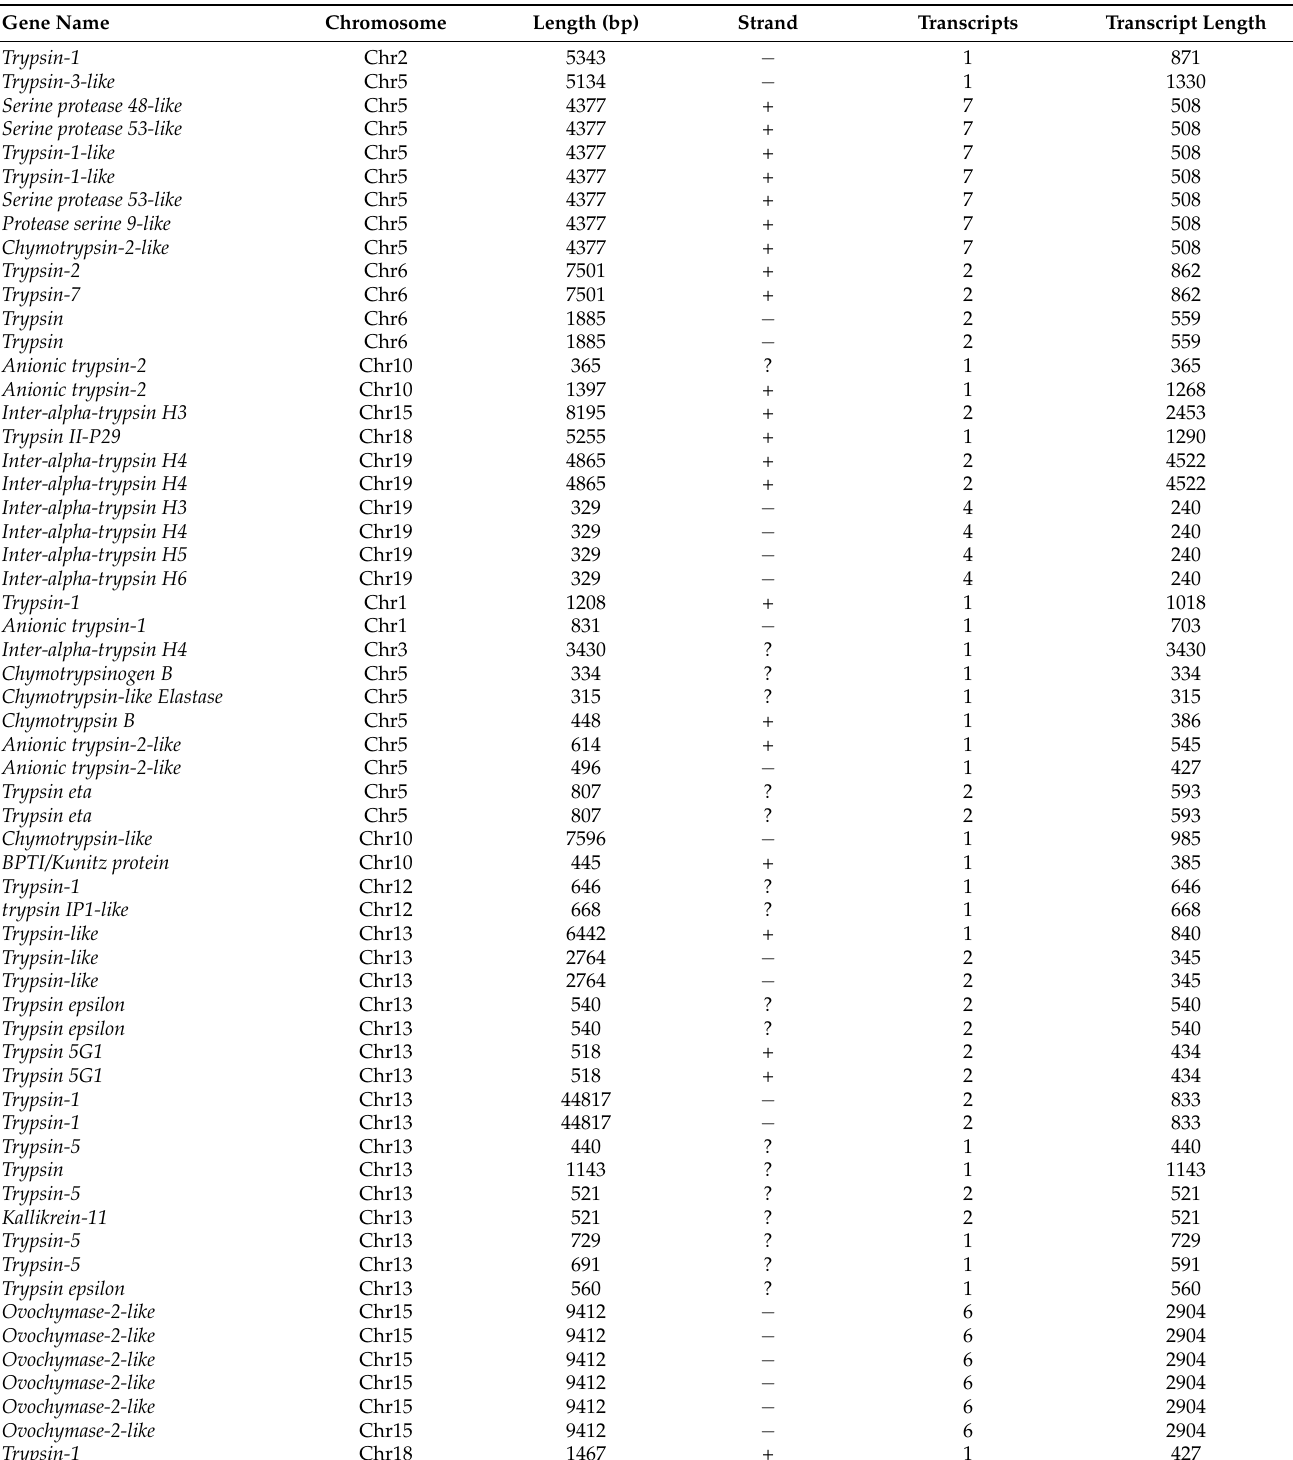
Table 1. Trypsin genes identified in the Caligus rogercresseyi